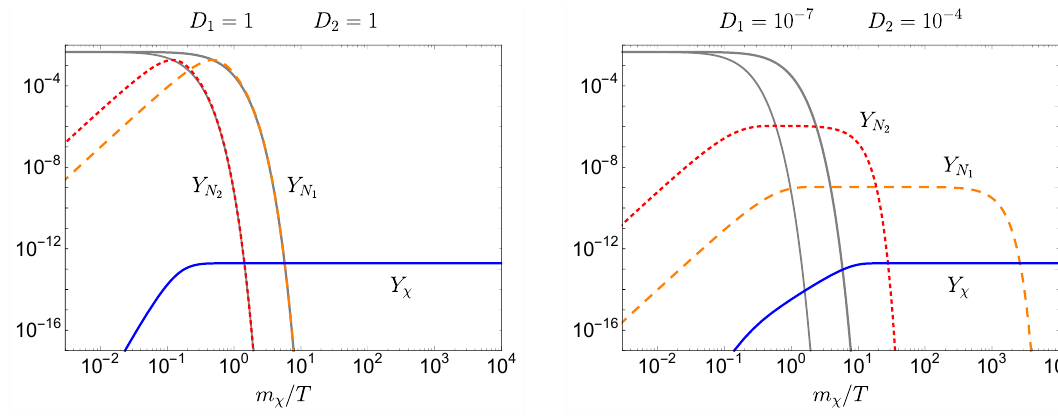
= 5 TeV, M N = 20 TeV, 1 2 =H ( T = M N ) are changed. In the i ! B i